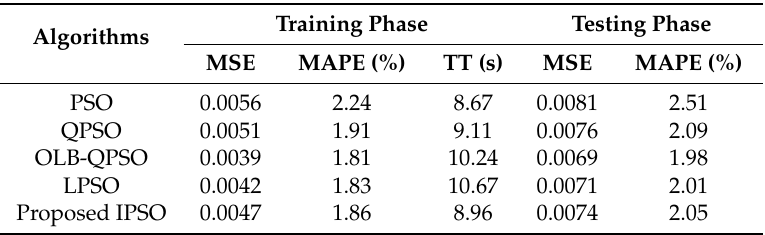
Table 4. Performance indices of five algorithms for optimizing the FNN model.